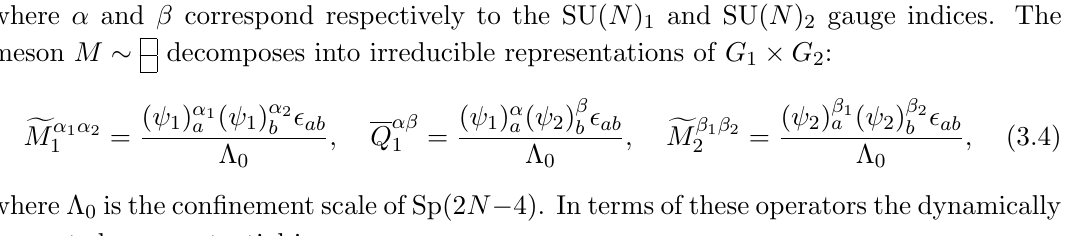
Figure 3 . The matter content of the SU( N ) ‘ is depicted in the moose diagram above, with Sp 2 n the A 0 (cid:12)elds is broken explicitly by the tree-level superpotential eq.